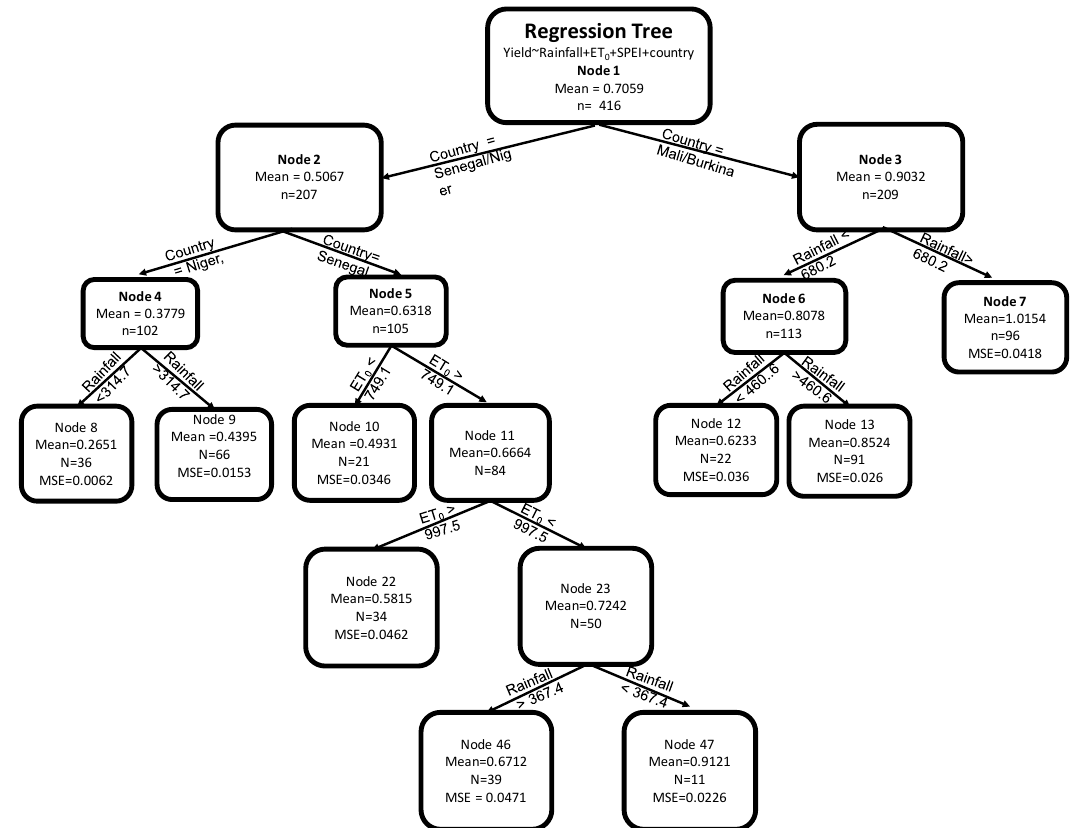
Figure 9. The regression tree for yield across all regions using seasonal precipitation, seasonal ET 0 , and seasonal SPEI to classify the yield into classes. Seasonal SPEI was ultimately not used for splitting the data in this regression